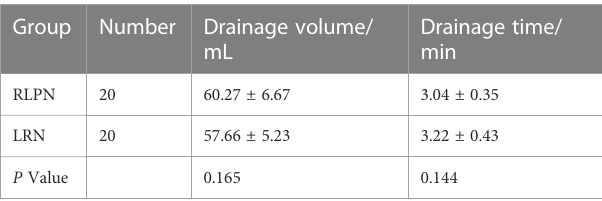
TABLE 2 The Drainage related